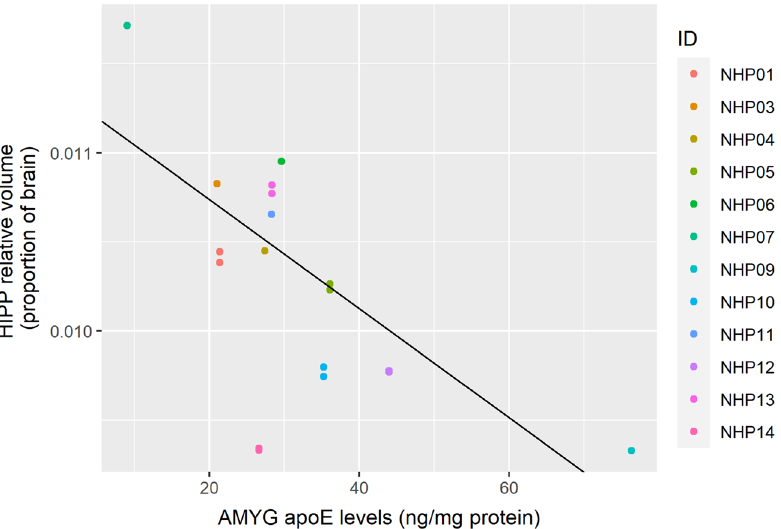
Figure 6. Levels of apoE in the AMYG negatively predicts relative HIPP volume. The figure shows results from a GEE model using HIPP apoE levels as the sole predictor. Individual macaque IDs are distinctly colored.